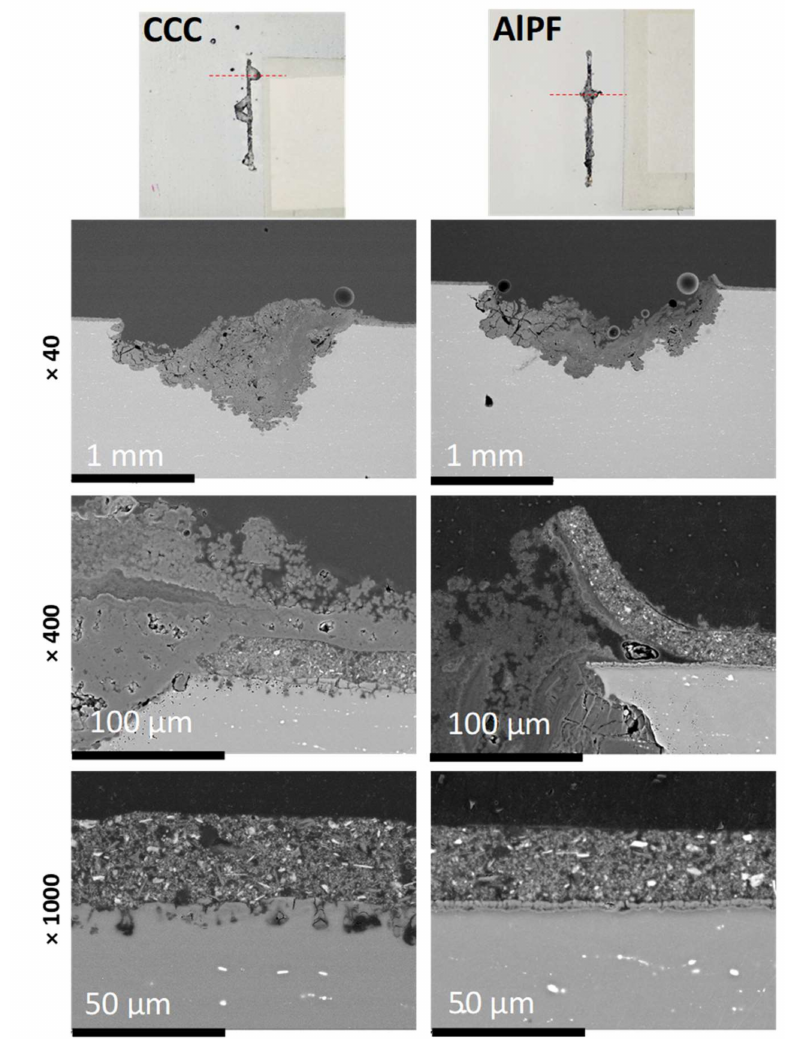
Figure 5. Macrographs of corrosion progress on AlPF and CCC painted and scratched samples after one week of NSST and after removal of the corrosion products with corresponding rating evaluations. SEM backscattered electrons imaging (BEI) cross-sectional micrographs illustrate the corrosion progress of the AlPF and CCC painted and scratched samples after one week of NSST: 40 × general view of the scratched surfaces, 400 × edge of the scratch, 1000 × far away from the